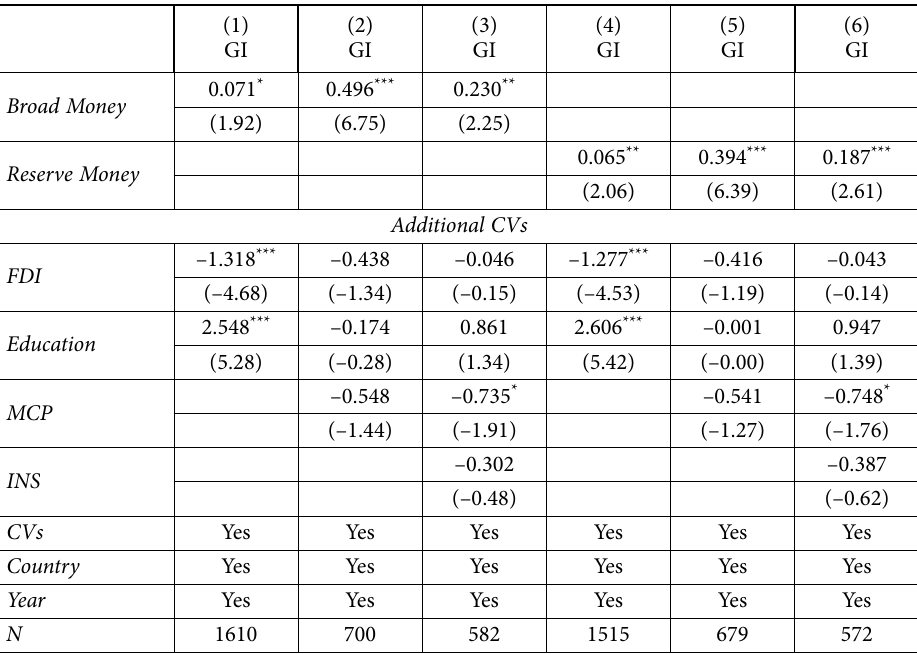
Table 5. Additional control